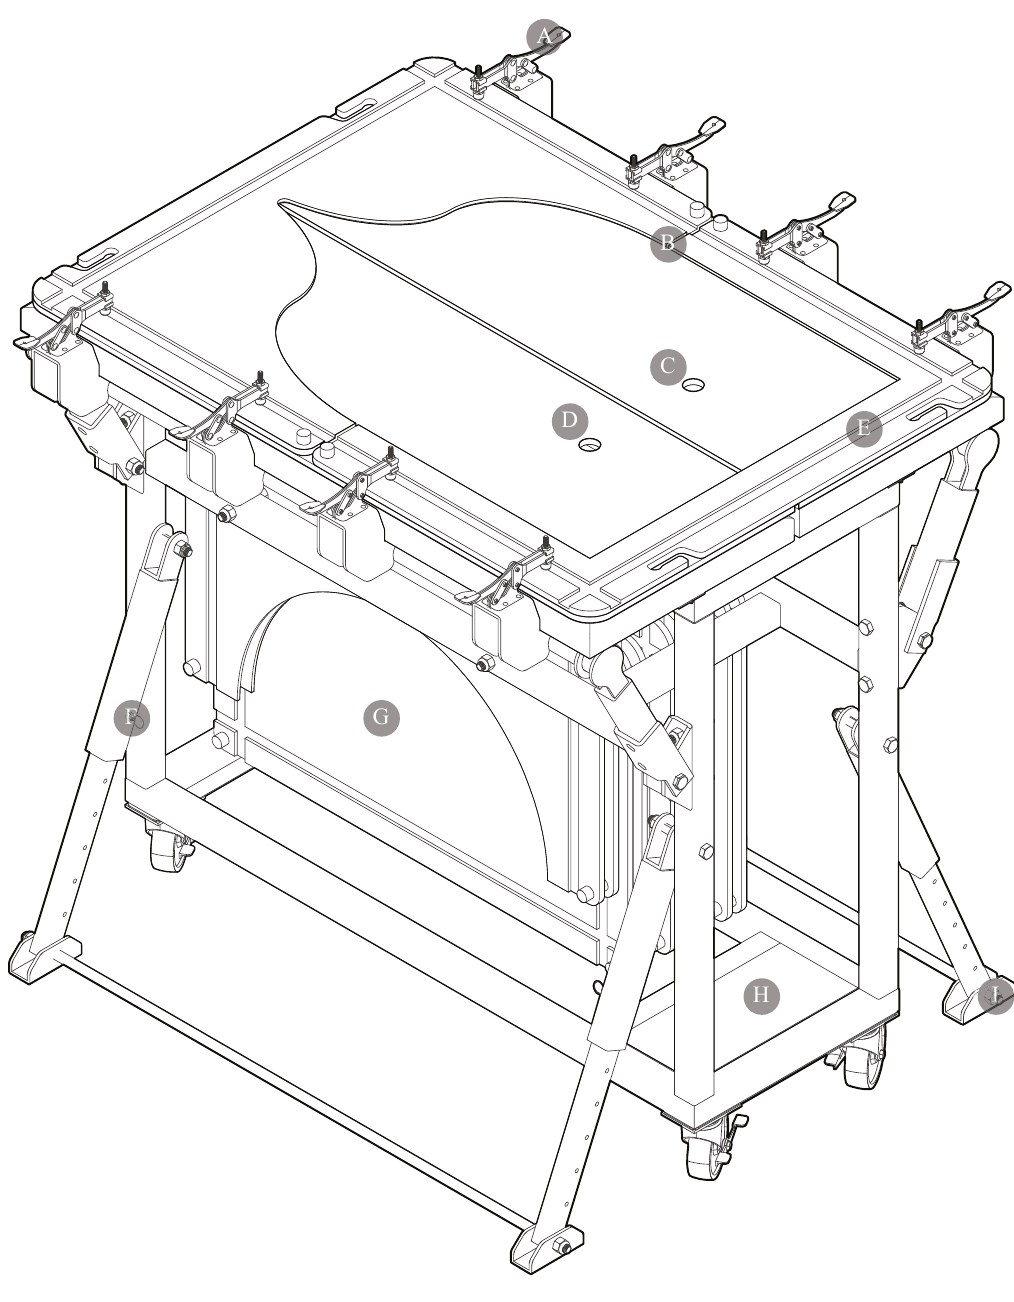
plate into double-sided rubber forming bladder (not shown). (D) water outlet pressure release safety valve from double-sided rubber forming bladder. (E) milled pocket for electromagnet fixing frame. (F) telescoping stabilisation strut spring-pin. (G) hanging storage for forming dies.(H) storage surface for pressure washer/pump. (I) stabilisation strut levelling foot. Source: